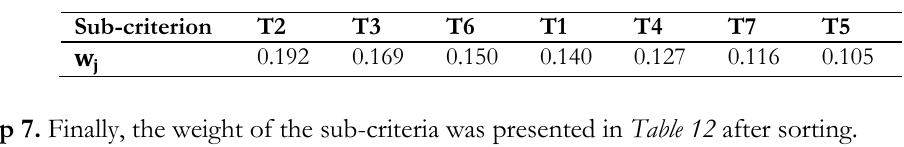
Table 11. The weight of each sub-criterion.